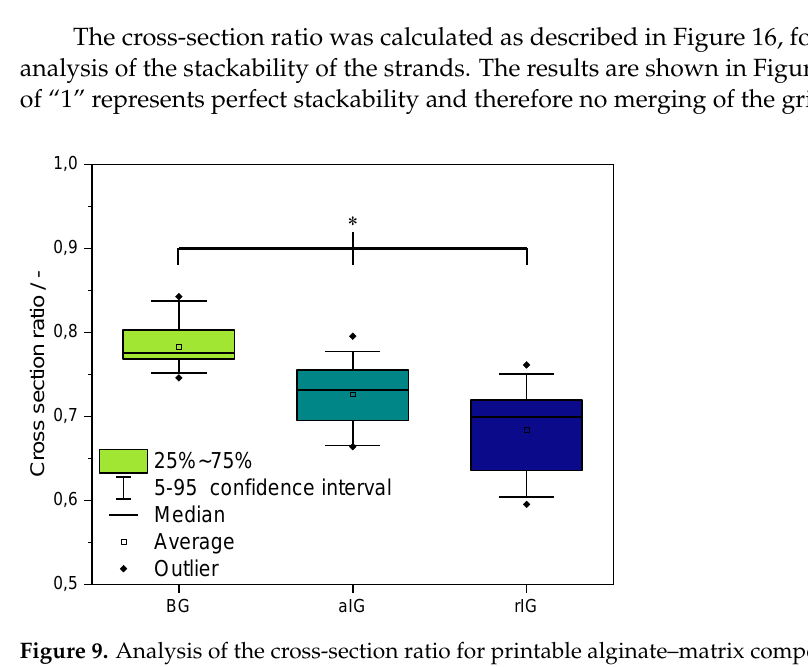
Figure 9. Analysis of the cross-section ratio for printable alginate–matrix composites (inks BG, aIG and rIG). Statistical analysis using one-way ANOVA indicated a significant difference (* p < 0.05) for all samples.